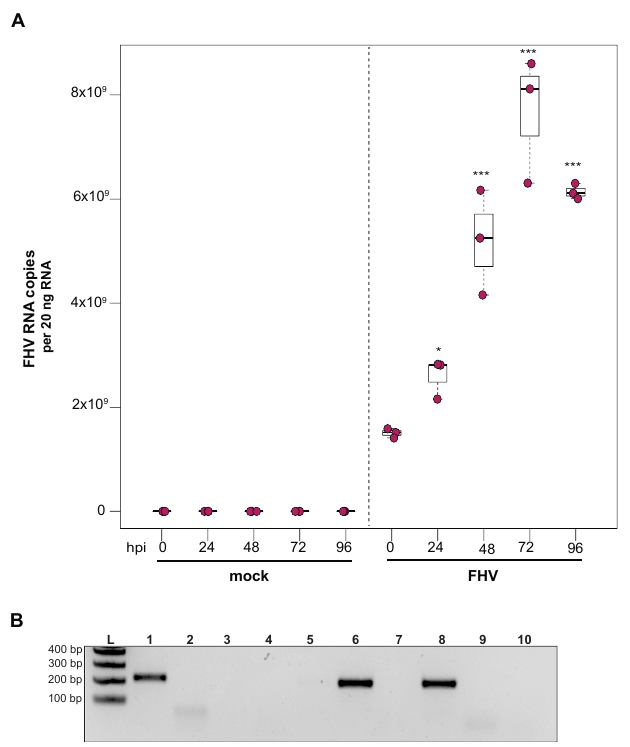
Figure 5. Flock House virus (FHV) replicates in primary honey bee pupal cells. Pupal cells were either mock- or FHV-infected (2 × 10 8 FHV RNA copies), and FHV abundance was quantified over a course of time (i.e., 0 hpi, 24 hpi, 48 hpi, 72 hpi, and 96 hpi). ( A ) FHV abundance increased at 24 hpi (1.7×, p = 0.024) and 48 hpi (3.4× p < 0.001), with a peak in FHV infection at 72 hpi (5×, p < 0.001), relative to 0 hpi. FHV abundance did not increase from 72 hpi to 96 hpi but remained 4× higher than at 0 hpi ( p < 0.001). Raw data are included in Supplemental Table S6. Figure 5 includes results from one representative biological replicate. The data for additional replicates are presented in Supplemental Figure S5. All differences in means relative to 0 hpi were assessed by a Dunnett’s test. Significance levels: * p < 0.05; *** p < 0.0005. ( B ) To validate that the increase in FHV abundance was indicative of virus replication, the presence of the negative strand (replicative intermediate) was assessed by negative-strand-specific RT followed by PCR. The negative strand was detected at 72 hpi (Lane 1) . Additional control reactions were performed using pooled RNA from time points 24–96 hpi (Lanes labeled 2–9). Specifically, RNA-isolated FHV containing cell lysate was reverse- transcribed with the primer listed below, treated with Exonuclease I to remove excess primer, and amplified using the PCR primers listed for each lane. (L) Molecular weight ladder. (1) 72 hpi RNA template—RT with FHV-TAGS-F, PCR with TAGS and FHV-Rev. (2) Negative control: No RT in the presence of (FHV-TAGS-F), PCR with TAGS and FHV-Rev. (3) Negative control: RT in the presence of (FHV-TAGS-F), PCR with only the FHV-Rev primer. (4) Negative control: RT with random hexamer primer, PCR with TAGS and FHV-Rev. (5) Negative control: No RT enzyme in the presence of random hexamers, PCR with FHV-F and FHV-Rev. (6) Positive control: RT with random hexamers, PCR with FHV-F and FHV-Rev. (7) Negative control: RT with random hexamers, PCR with only FHV-Rev primer. (8) Self-priming: RT without a primer, PCR with FHV-F and FHV-Rev. (9) Negative control: No template, no RT, PCR with TAGS and FHV-Rev. (10) Negative control: No template, no RT, PCR with FHV-F and FHV-Rev. Additional details provided in Supplemental Table